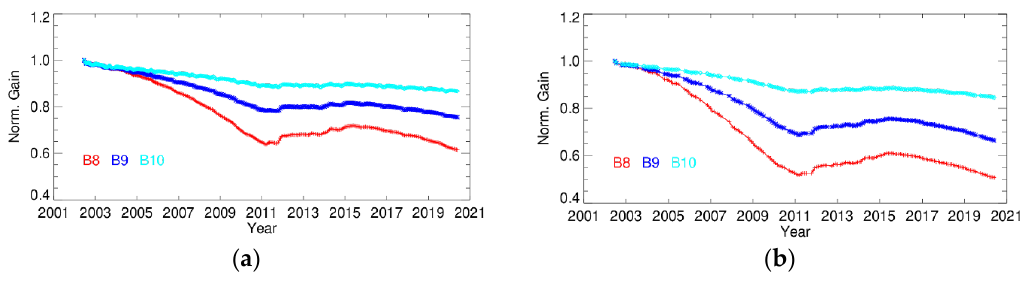
Figure 12. Normalized detector gains of Aqua MODIS visible (VIS) bands (8, 9, and 10) derived from SD ( a ) and lunar ( b ) observations (band averaged, mirror side 1).